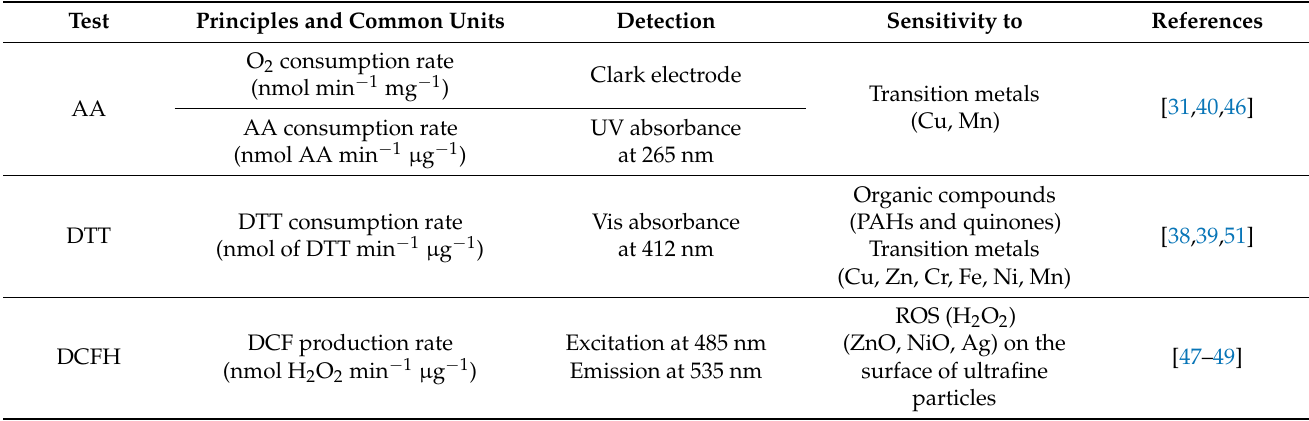
Table A2. Characteristics of the different cell-free tests to determine the oxidative potential of particles.